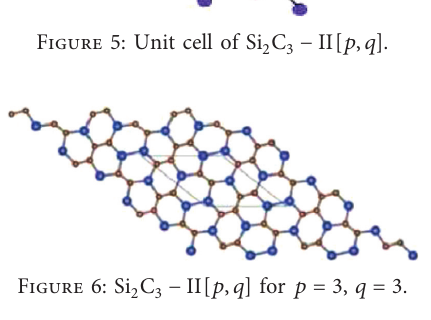
− II [ p, q ] for p � 3, q � 3. C 2 3